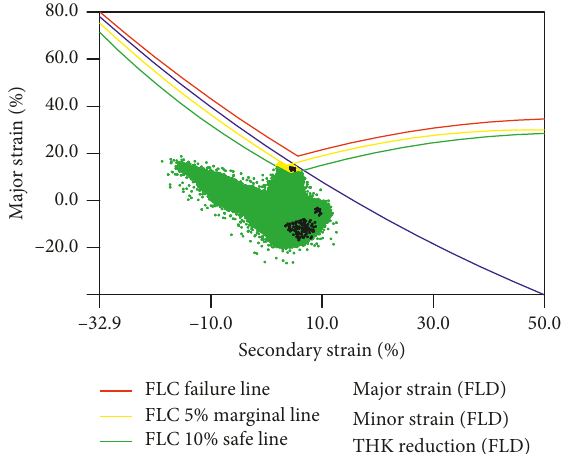
Figure 14: Frequency control curve.